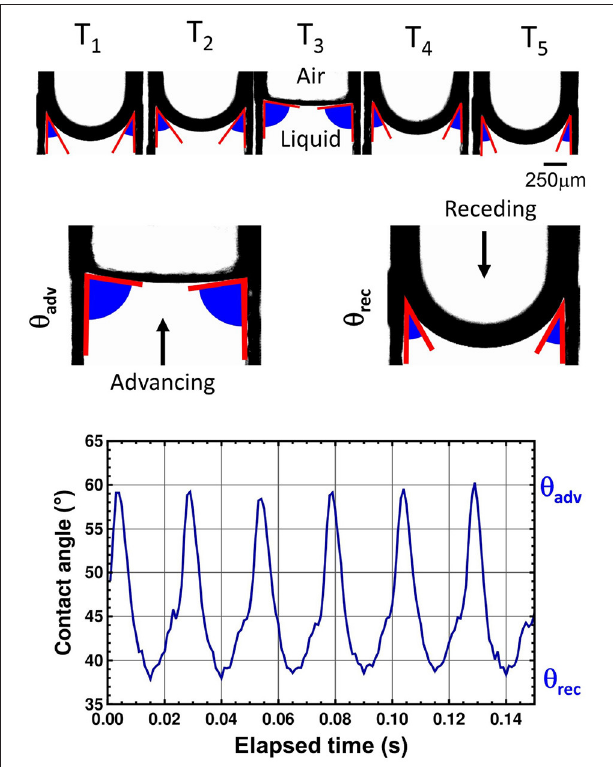
FIGURE 4 | Top : Interface profile at 5 time instants ( T 1 − T 5) during an oscillation cycle. Middle : The maximum contact angle is associated with the advancing stage of the cycle, while the minimum contact angle is associated with the receding stage of it. Bottom : Dynamic angle as a function of time obtained from the interface at the right of the fluid slug IF2 . Data are for PEO8 oscillating at 40 Hz, driven by a 1 p max = 900 Pa .